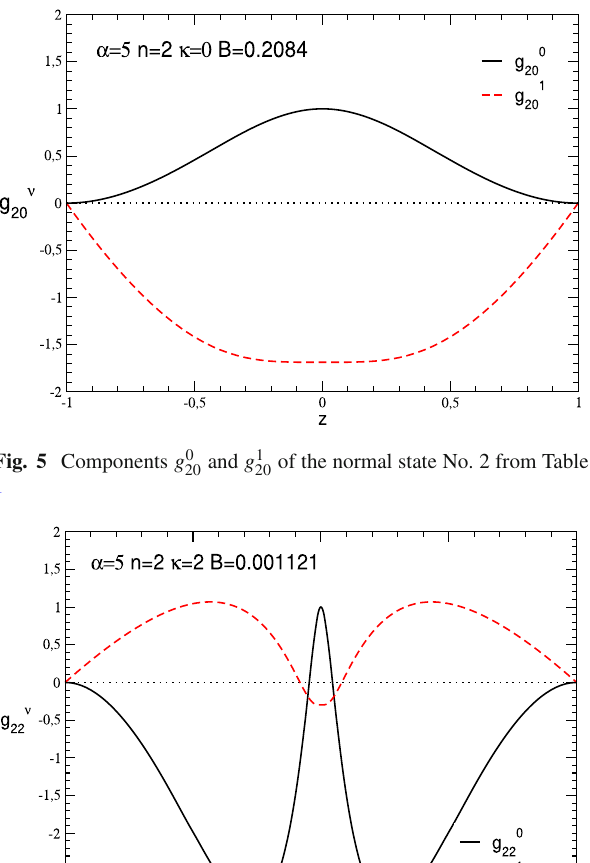
Fig. 6 g 0 and g 1 (scaled by a factor 10 3 ) of the abnormal state No. 22 22 4 (Table